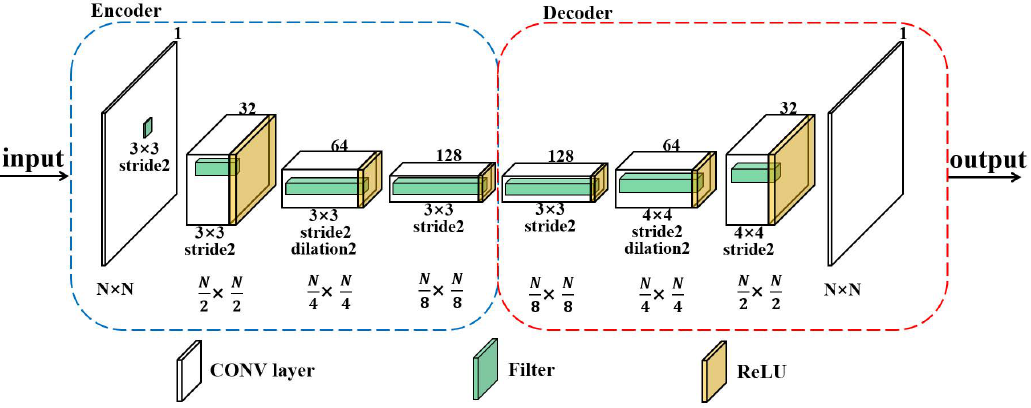
Figure 5. The structure of the